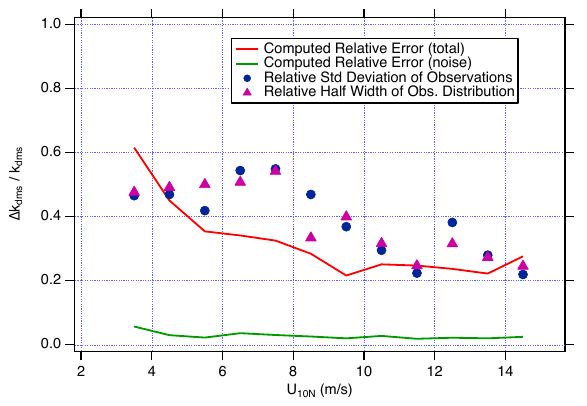
Fig. 9. Computed relative error and RSD of the observations from the Southern Ocean GASEX project. Flux results were selected for a narrow range of sea surface temperatures (4–7 ◦ C). Error was computed for hourly observations ( n =329) from Eq. (23) with con- stant a = 2. Observed flux and computed error were normalized to the observed sea water DMS concentration, yielding transfer ve- locity: k dms and 1k dms . These results were binned by the 10-m neutral stability wind speed, U 10N and the RSD and distribution half-width of the observed k dms were computed. Absolute error was further normalized to yield relative error ( 1k dms / k dms ). The computed error (red line) is in general agreement with the RSD and distribution-width of the binned observations (blue and pink sym- bols). The white noise contribution from the second term in (23) (green line) is less than 20 percent of total computed